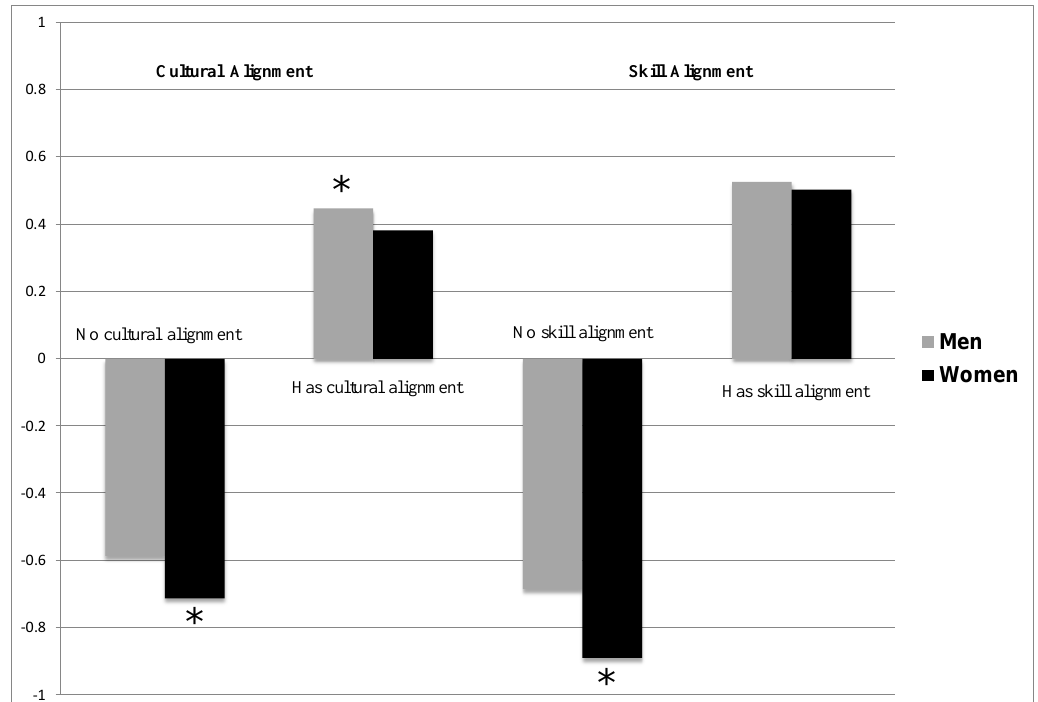
Figure 4. Gap between Self-Ratings and Ratings of Successful Tech Workers by Direction and Gender (Simard et al. 2007). N = 1582. Note: Alignment is defined as a zero or positive gap between self-ratings and ratings of successful tech workers, and non-alignment is defined as a negative gap. The y-axis displays the average successful tech worker rating subtracted from the average self-rating for each group.